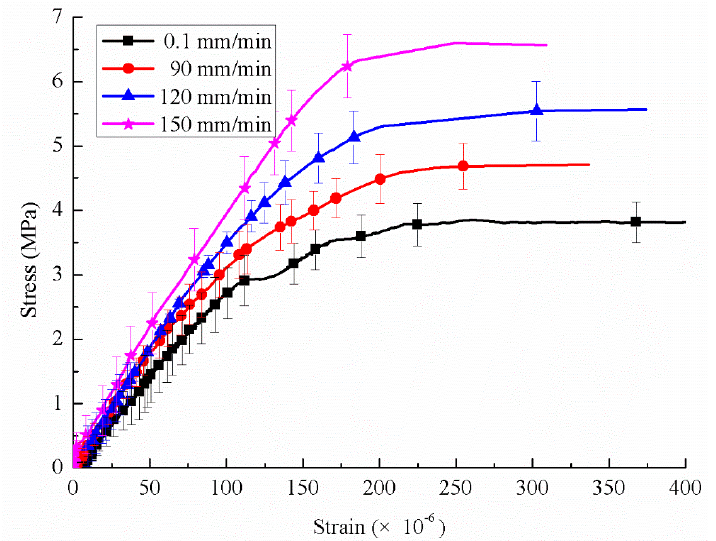
Figure 11. Stress-strain response of concrete under di ff erent loading velocities (skip every 5 points).